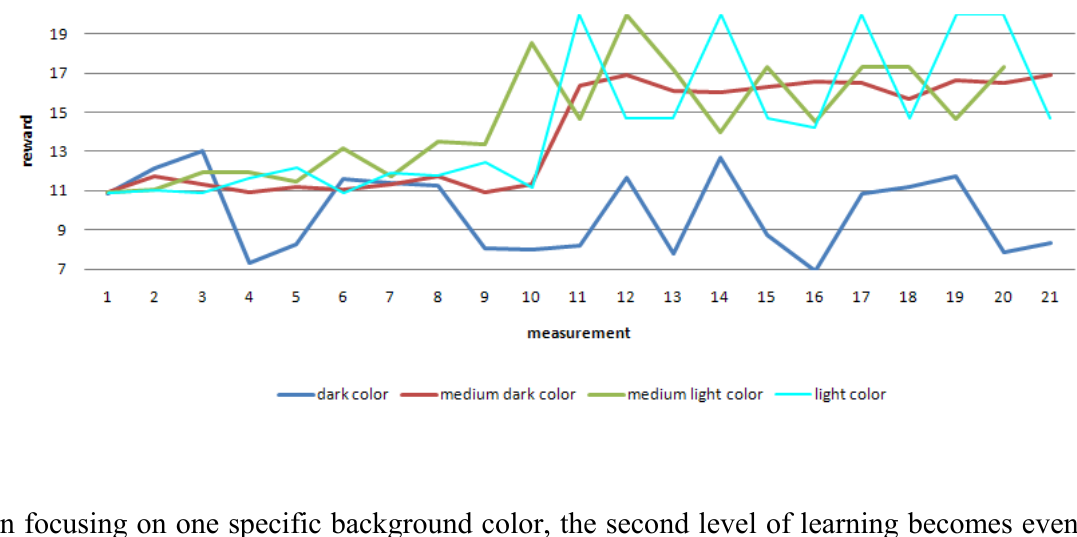
Figure 11. Performance of a mobile sensor with lower randomness when learning from its